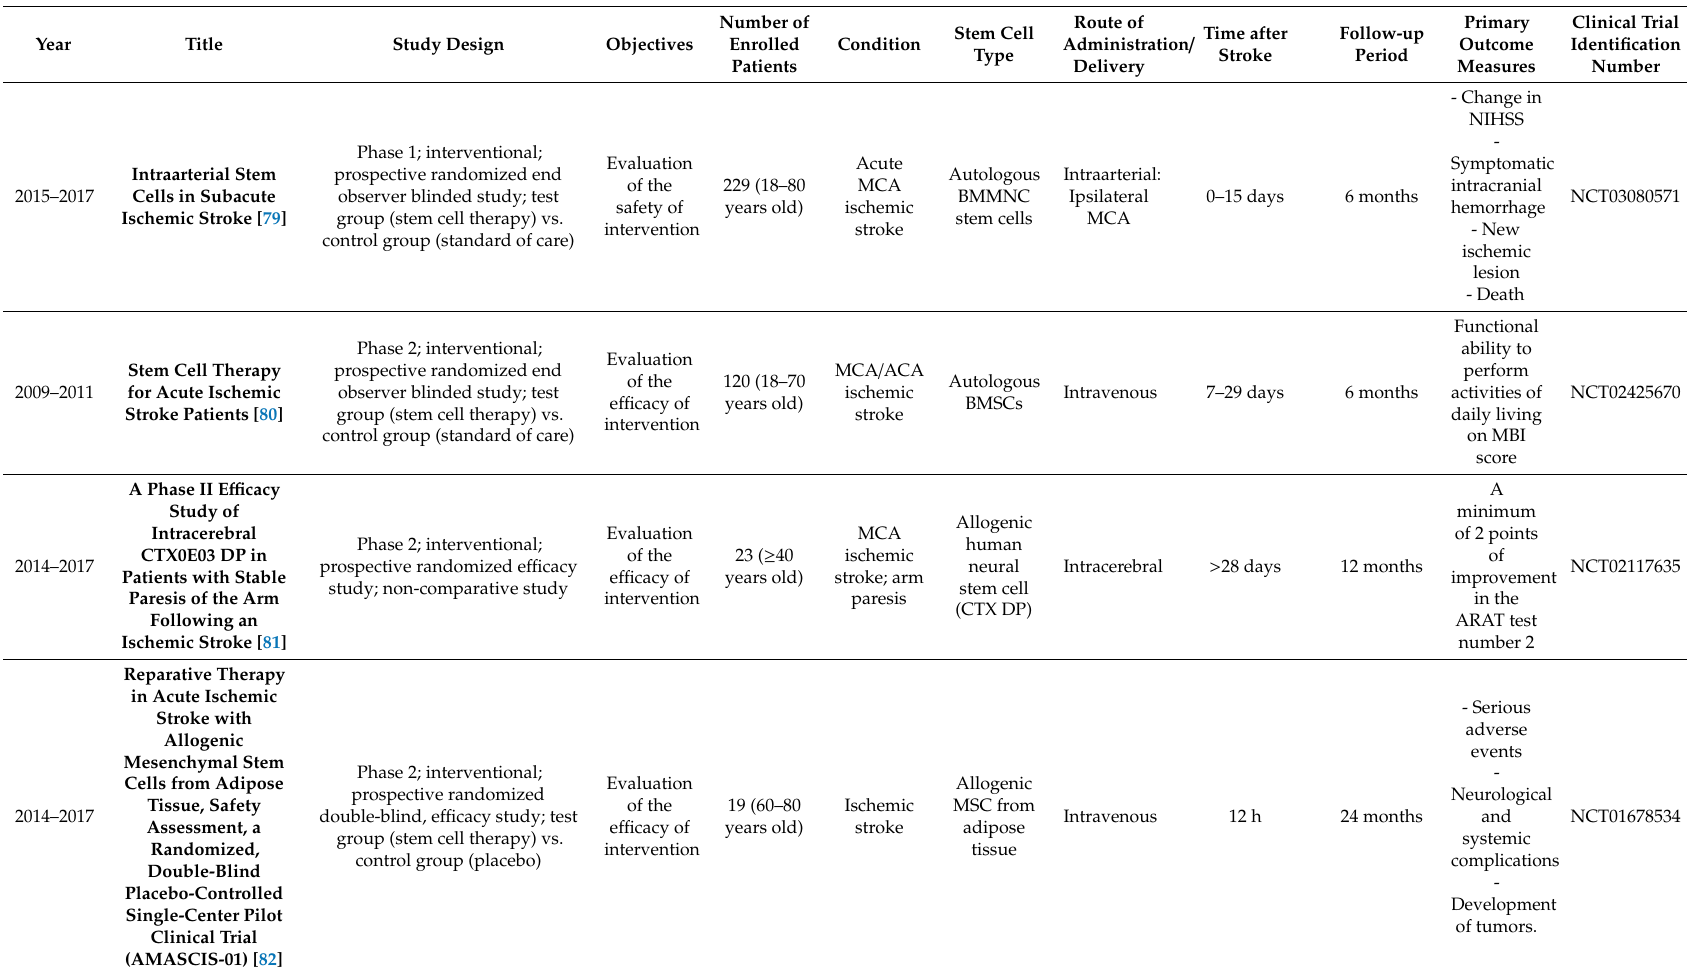
Table 1. Completed clinical trials on stem cell research in ischemic stroke patients in the clinicaltrials.gov